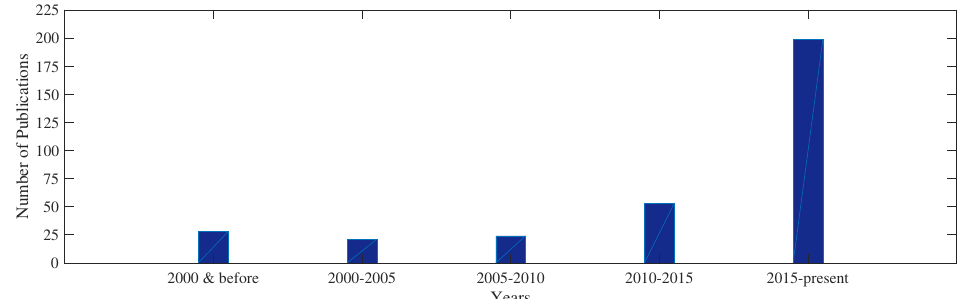
Figure 8. Reviewed number of publications per time